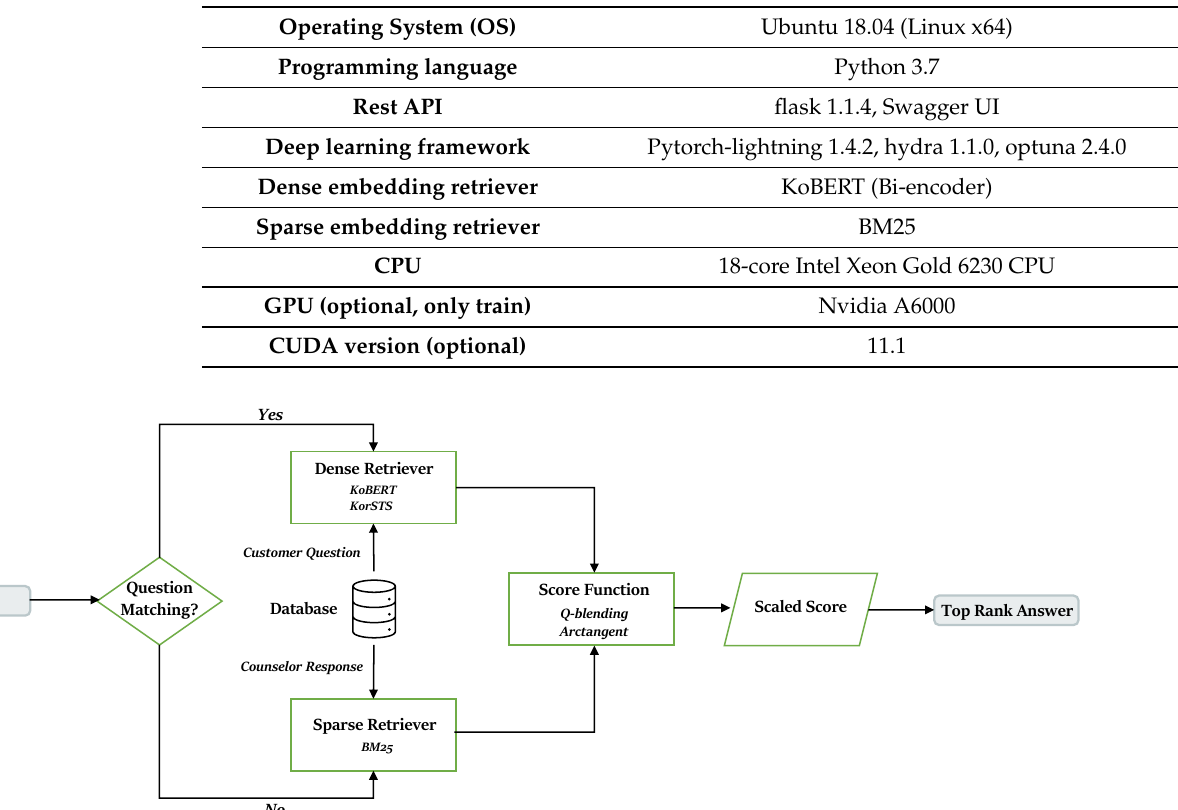
Table A1. Technical details of proposed FAQ retriever system. GPU resource is used only for training the KoBERT model, not required in the inference process.